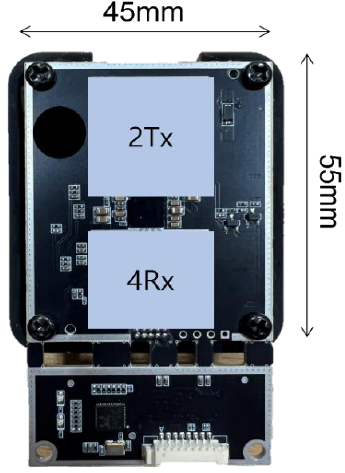
Figure 4. FMCW radar.